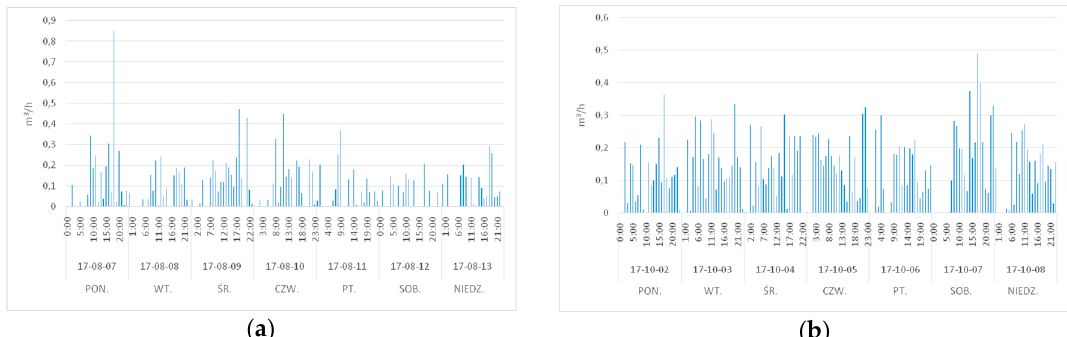
Figure 2. The maximum of momentary volumetric flows in selected single-family houses: ( a ) building no. 1, ( b ) building no. 7.